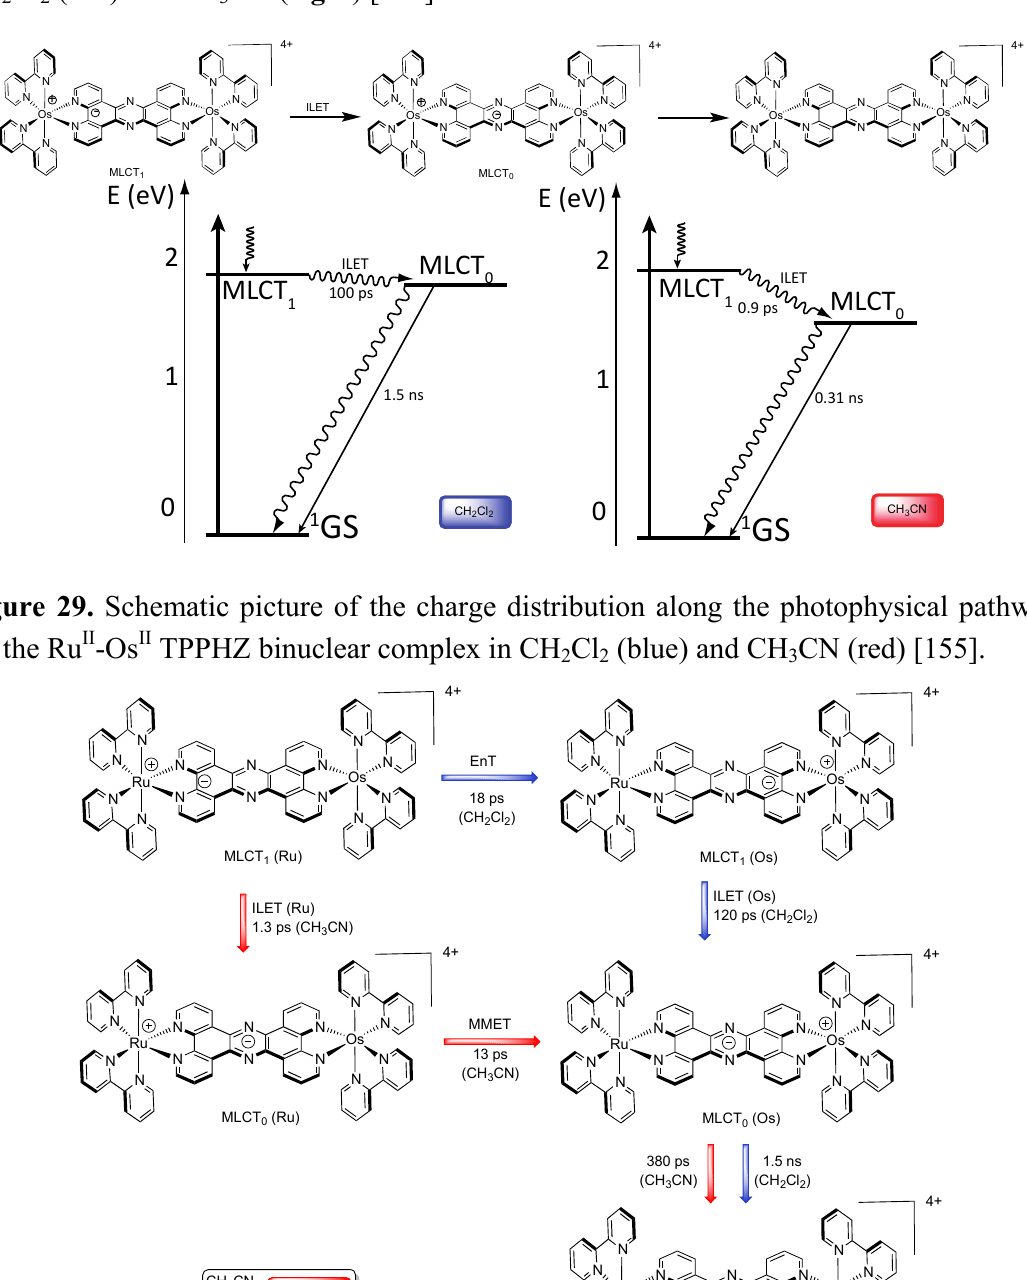
Figure 28. Photophysical mechanism for the Os II -Os II TPPHZ binuclear complex in CH Cl ( left ) and CH CN ( right ) [155]. 2 2 3